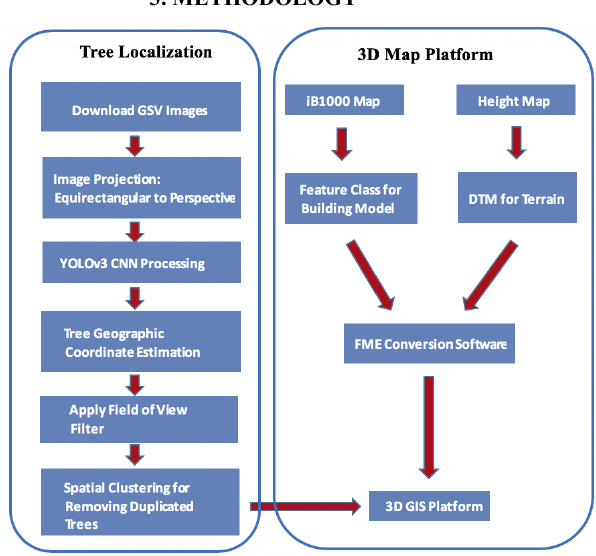
Figure 1. Workflow for automated tree detection and visualization in 3D Map platform